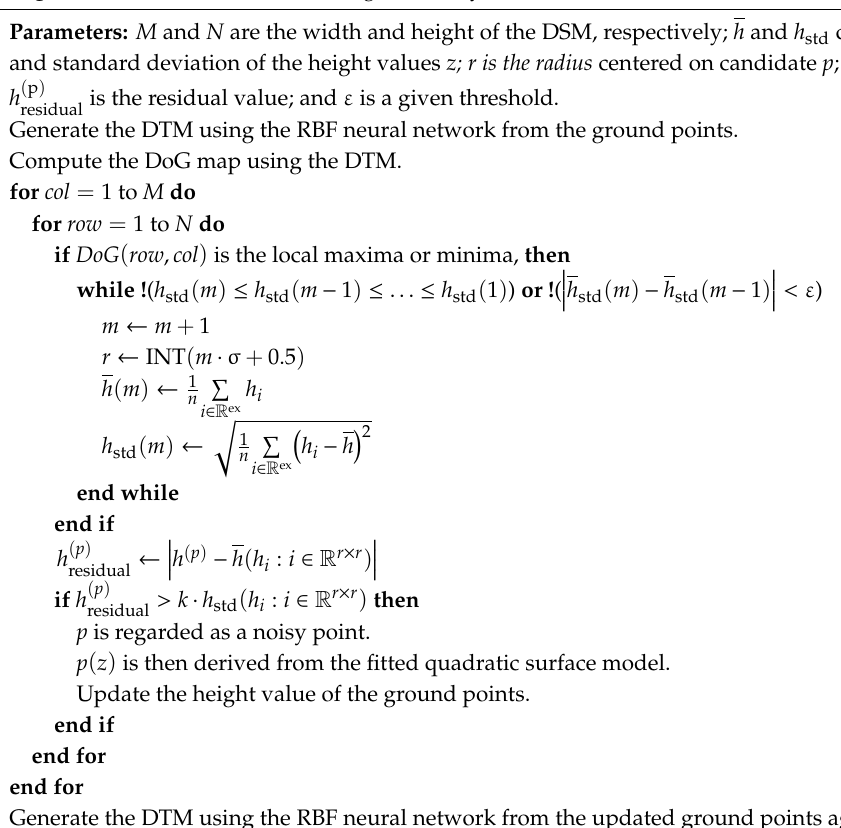
Figure 7. DTMs and CHMs of the two forest plantations. ( a , b ) are the DTMs of Plantations 1 and 2, respectively. ( c , d ) are the CHMs of Plantations 1 and 2, correspondingly. DTMs: digital terrain models; CHMs: canopy height models. Algorithm 1: RBF neural network against noisy